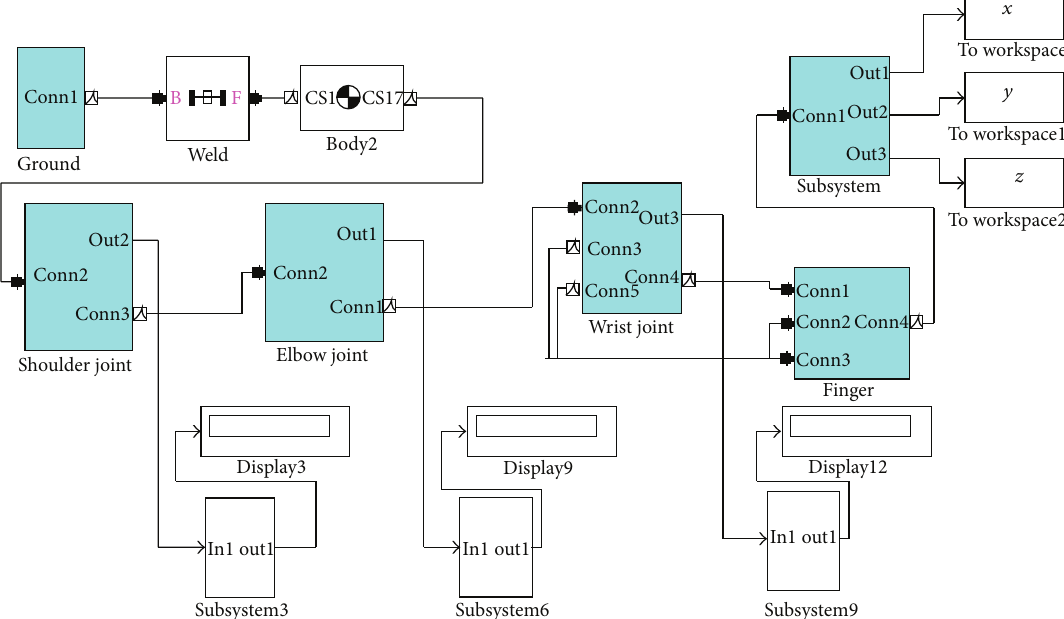
Figure 14: Human arm model in